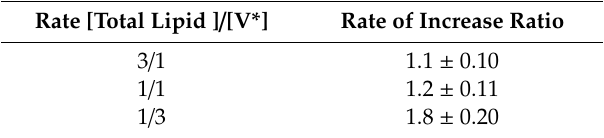
Table 5. Dependence of the relative concentration of V* on the rate of increase ratios of GV-based artificial